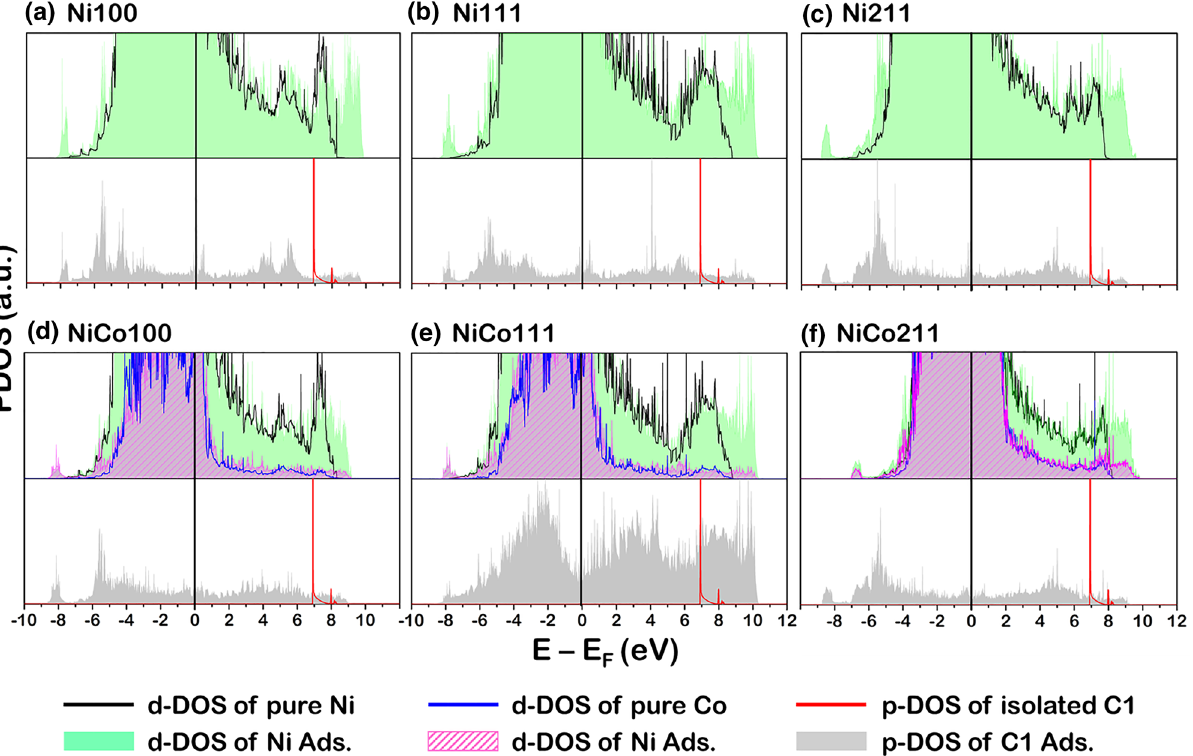
Figure 10. The PDOS profiles of fresh and 2-atom-carbon (C2)—adsorbed catalyst surface: ( a ) Ni100, ( b ) Ni111, ( c ) Ni211, ( d ) NiCo100, ( e ) NiCo111, and ( f ) NiCo211 surfaces. The top panel is the PDOS of the fresh and coked surface, while the bottom panel is the isolated and adsorbed C2